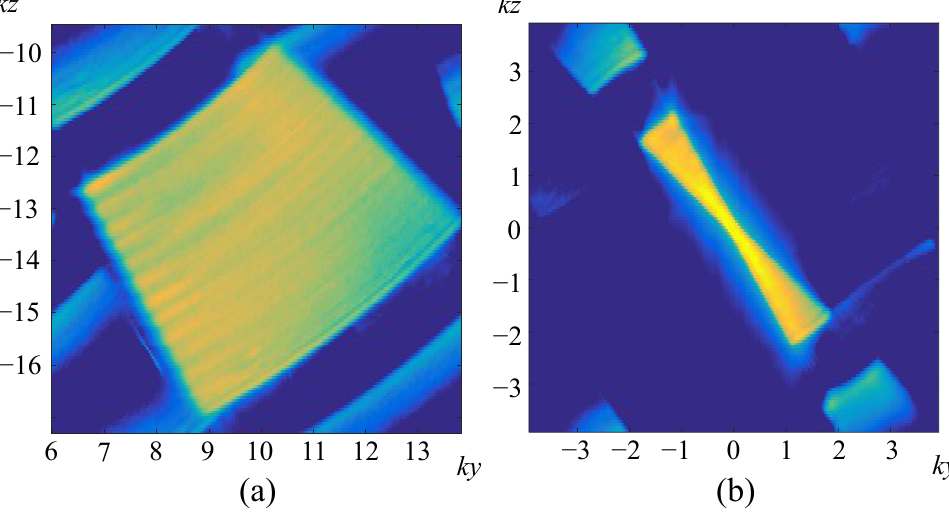
Figure 7. The leftmost panel ( a ) shows the 2D Fourier transform of real back-projected tomographic profiles in the { ky , kz } domain. The rightmost panel ( b ) shows the characteristic butterfely-shaped spectrum after the demodulation depicted in Figure 6 and described by Equation